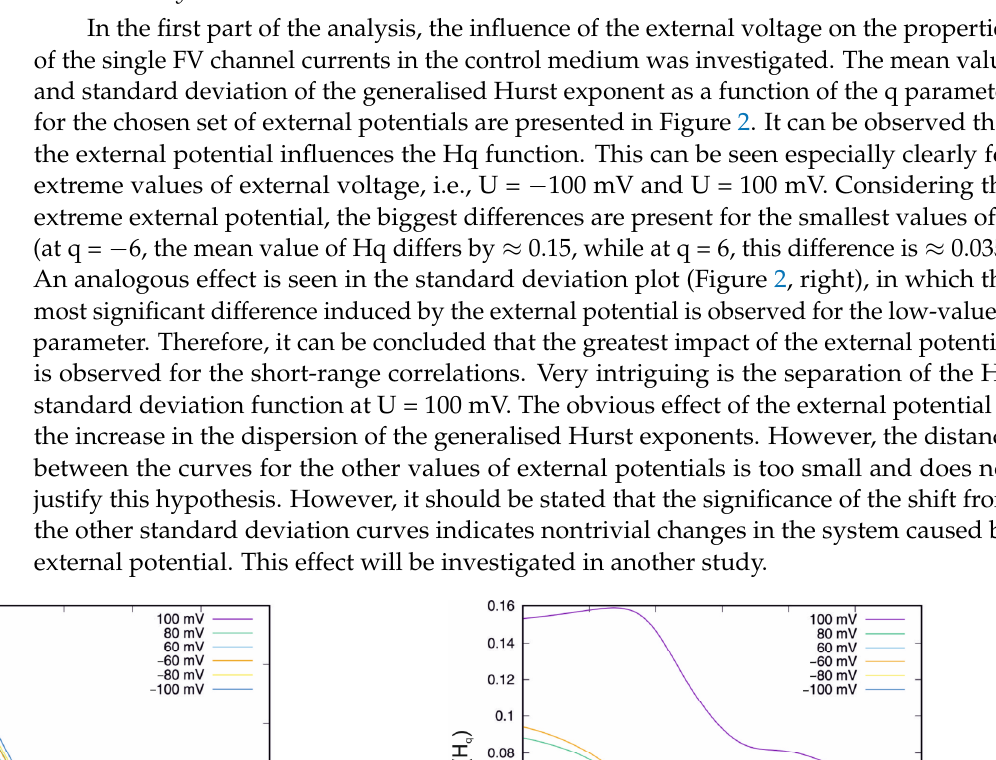
Figure 3. Singularity spectrum f ( α ) obtained for the given set of external potentials.